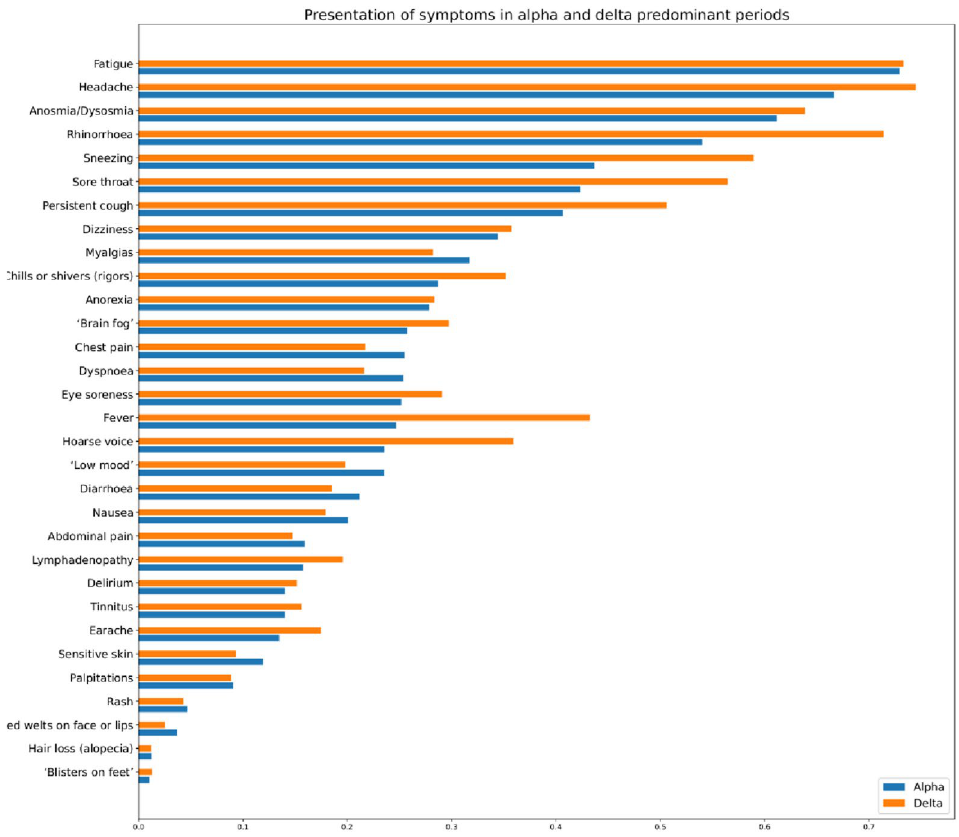
Figure 1. Prevalence of symptoms reported over the course of illness (up to 28 days) in individuals with COVID-19 during periods of SARS-CoV-2 Alpha or Delta variant predominance. Data are matched for age and sex but unmatched for local viral prevalence, lock-down restrictions, or